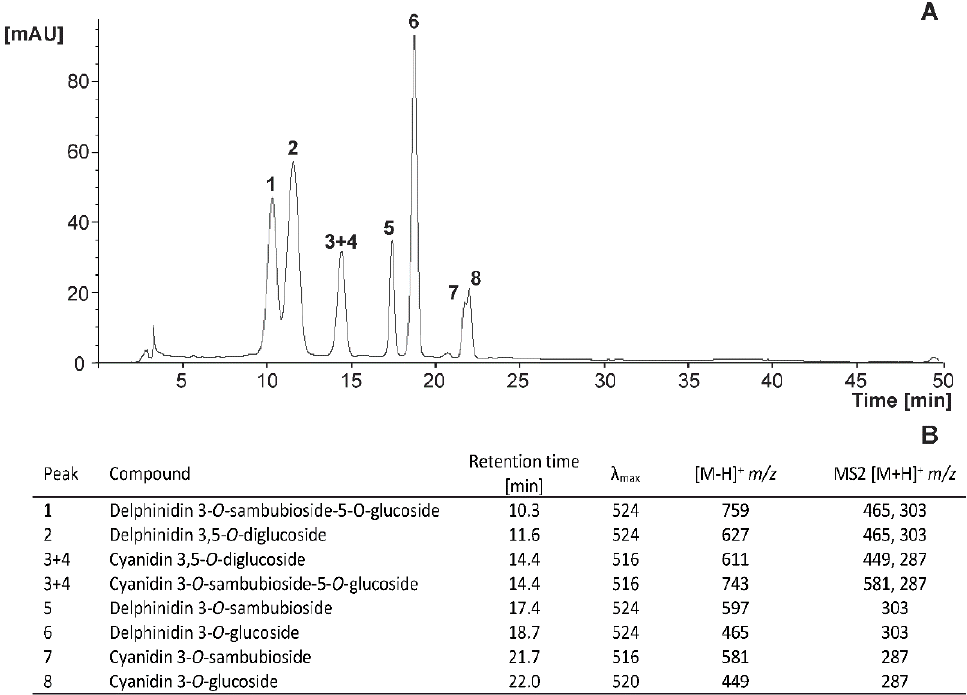
Figure 5. Representative chromatogram of the maqui-citrus juices recorded at 520 nm ( A ) and identity of the anthocyanins identified ( B ).